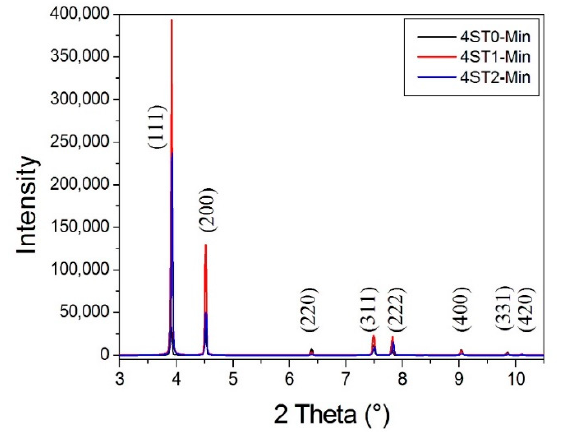
Figure 7. Diffraction patterns of 4ST tubes at Min for the integration sectors along the drawing direction.